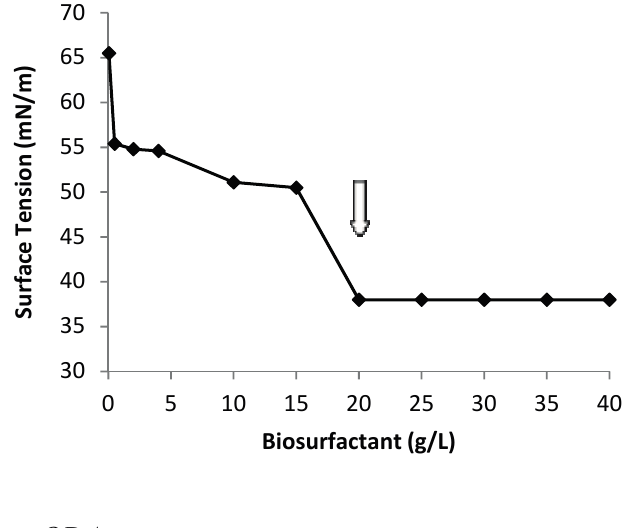
Cunninghamella echinulata grown in soybean oil waste (SOW) and corn steep liquor (CSL) as substrates, added to basic saline solution on the Critical Micelar Concentration